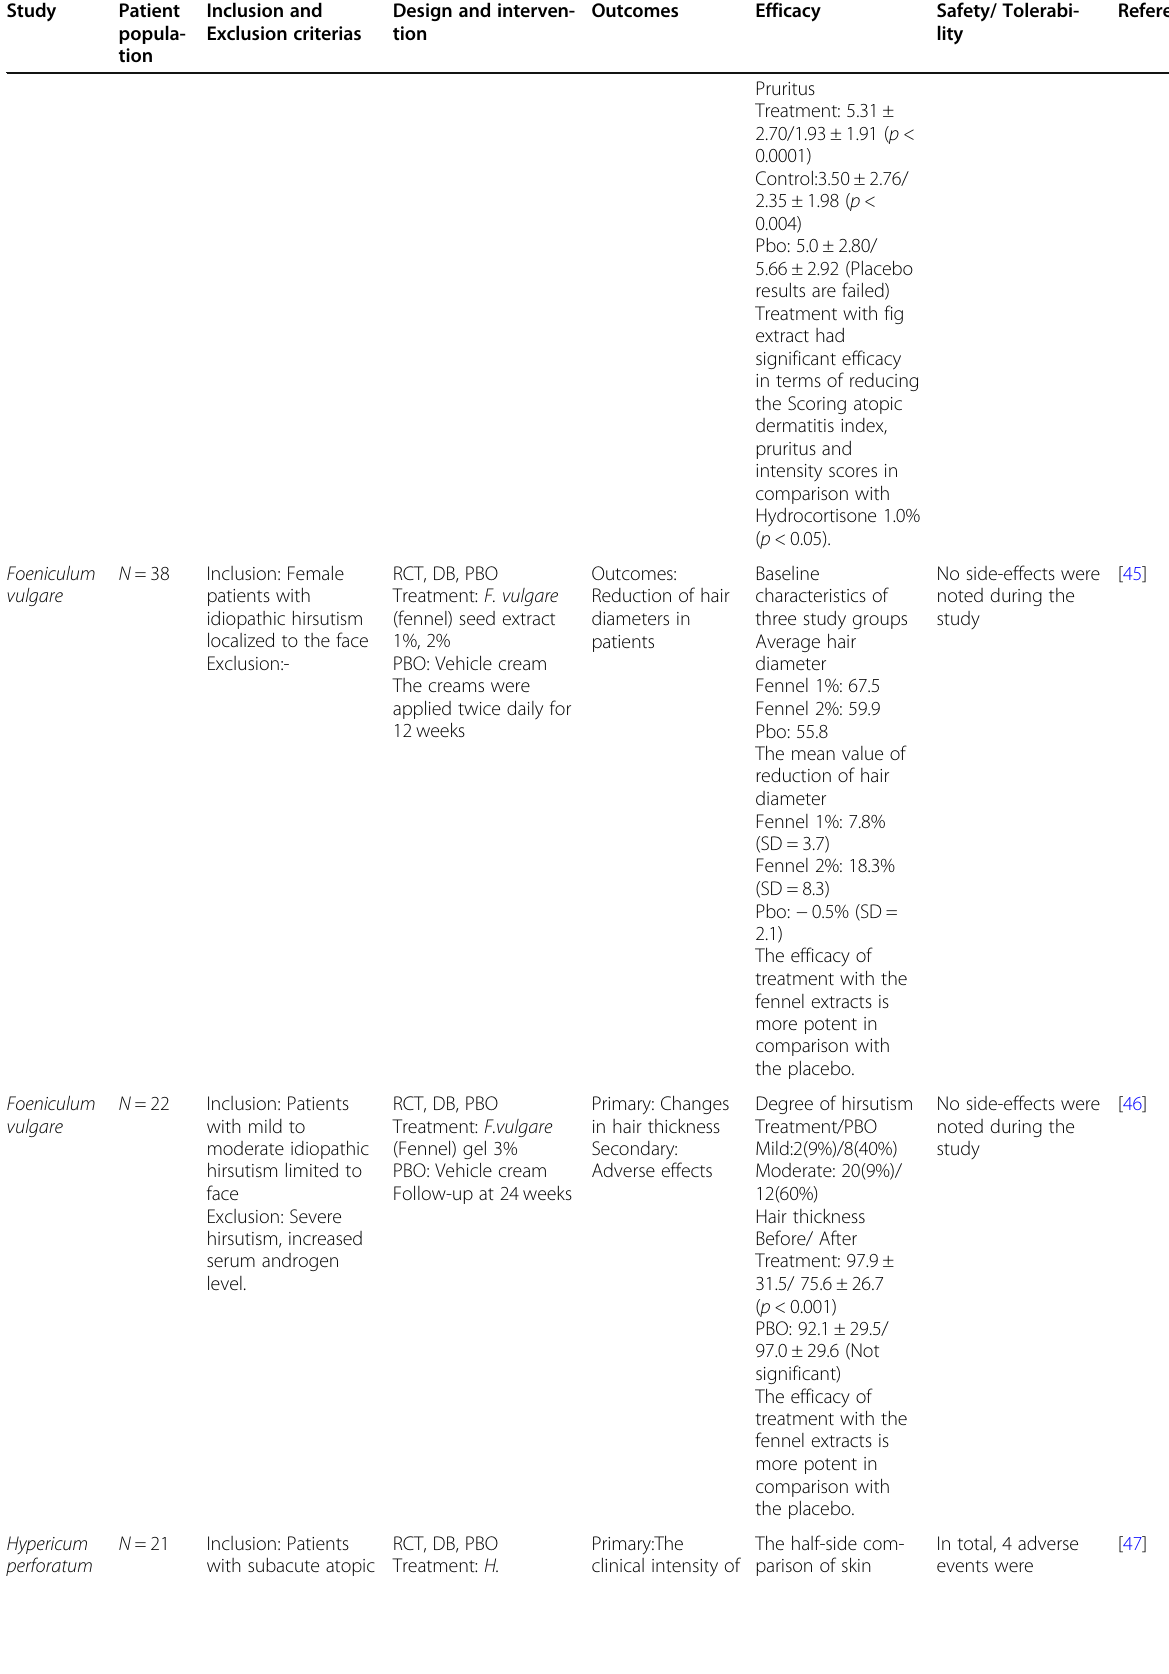
Table 4 Clinical trials of the traditional plants used for skin problems in Turkey (Continued)